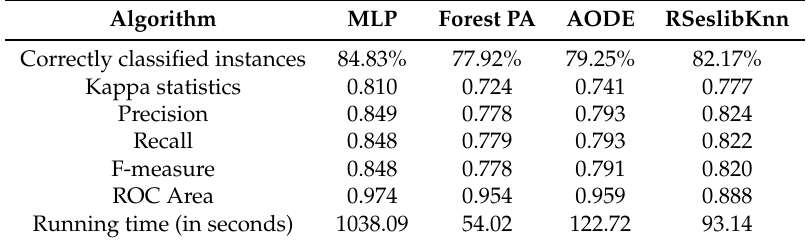
Table 1. The performance for each of the applied algorithms before attribute